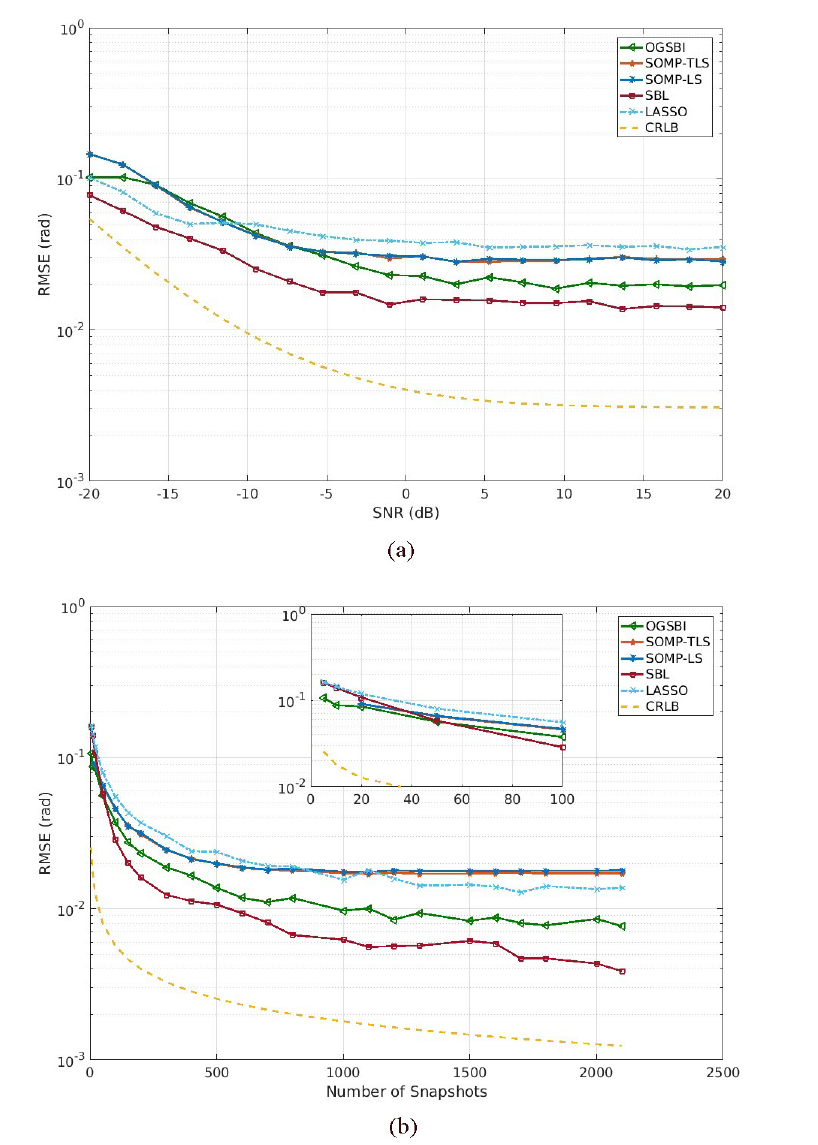
Figure 4. Estimation accuracy for 12 wideband signals based on coprime array. ( a ) RMSE vs. input SNR with T = 200 snapshots. ( b ) RMSE vs. the number of snapshots with SNR = 0